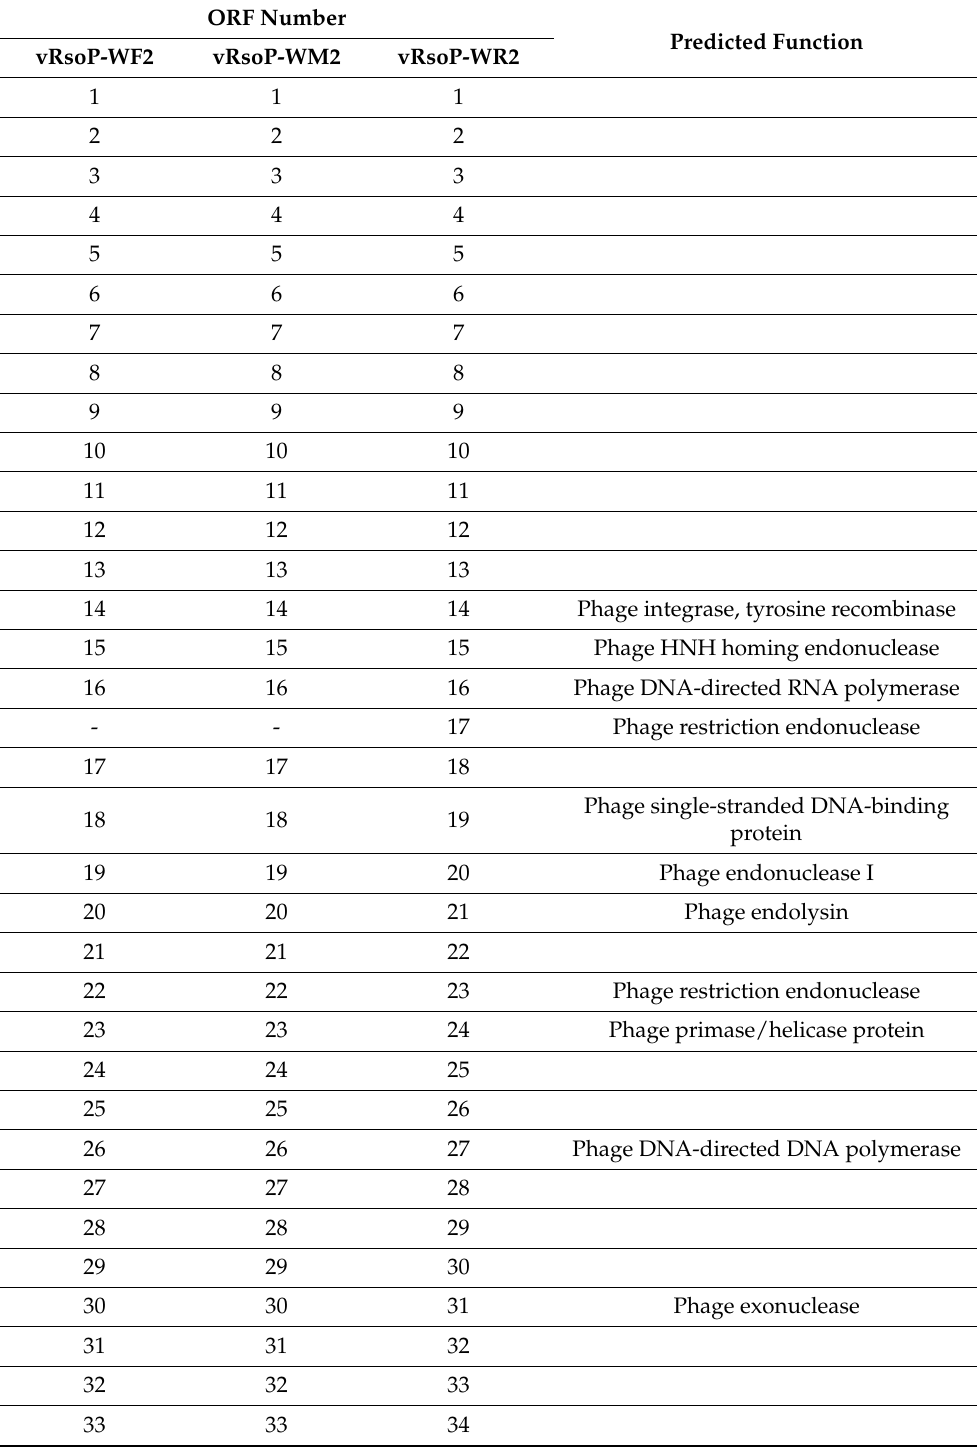
Predicted Function